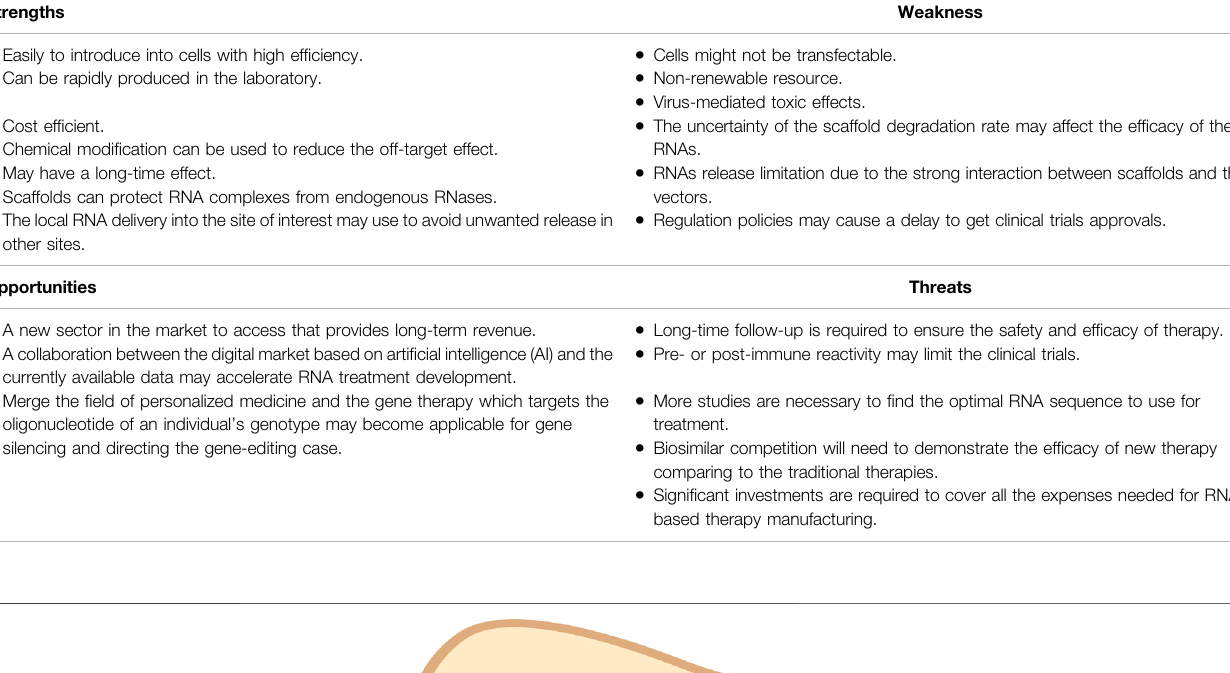
TABLE 1 | The SWOT analysis of using scaffolds based on RNA-gene therapy. Strengths Weakness